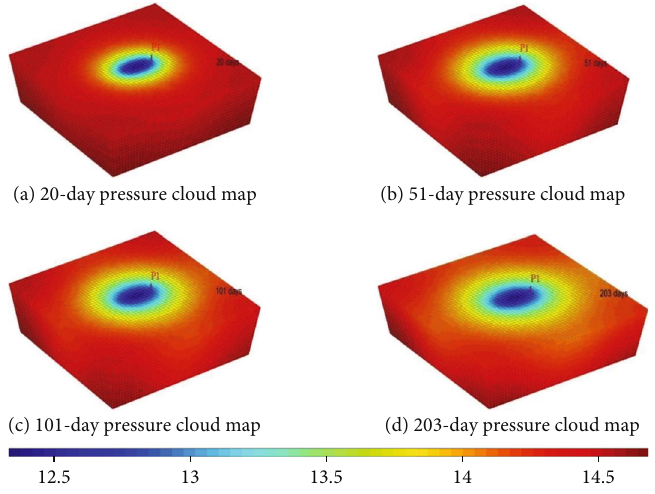
Figure 7: Pressure cloud diagram of horizontal well in anisotropic reservoir at di ff erent production times.